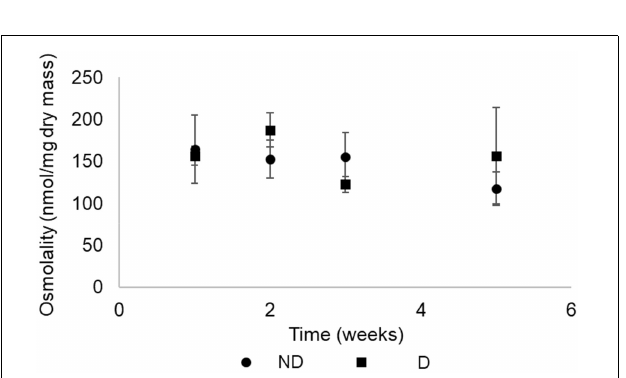
FIGURE 6 | Activity of food-deprived (starved) insects kept at 60% RH (no desiccation, ND) or 10 ± 2% RH (desiccation, D) for 2 weeks. The assay was also conducted at the start of the experiment, allowing us to obtain an estimate of the activity of the beetles reared under optimal laboratory conditions. Activity was measured as the number of times an individual crossed a line in a Petri Dish whose bottom was covered with a line grid. The boxplots present median (horizontal line), 25th and 75 percentiles (box), and the standard deviation (error bars) of the recorded activity. Star (*) indicates significant difference from the two other groups, as revealed by pairwise t -tests ( P < 0.001) following a one-way